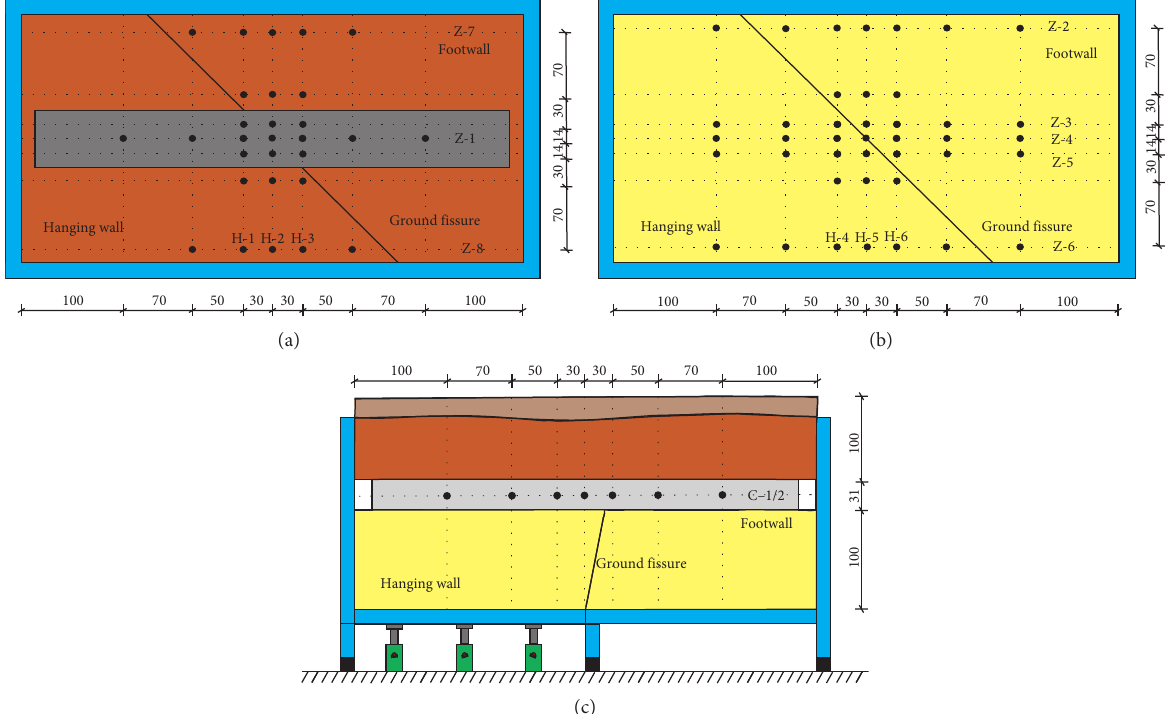
Figure 8: Earth pressure box layout (cm). (a) Top earth pressure box layout (cm). (b) Bottom earth pressure box layout (cm). (c) Layout of earth pressure box on the left and right side of the structure (cm).